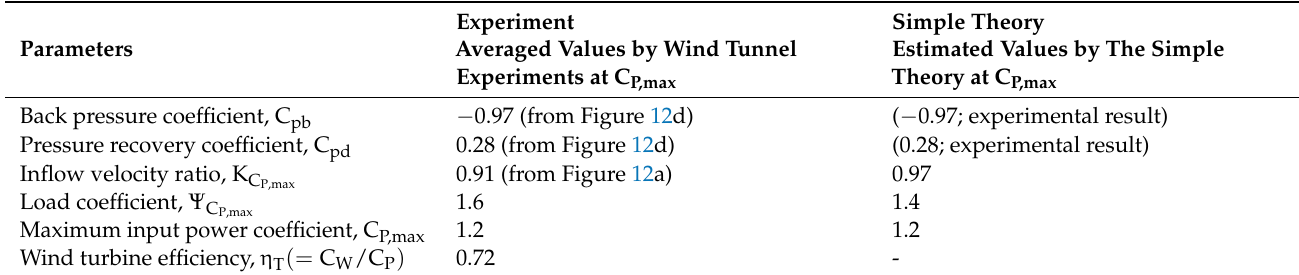
Table 4. Comparison of various coefficients between experiments and predictions by the simple theory at C P,max (at λ = 4.0) for a wind turbine with the compact Bii brimmed diffuser shown in Figure